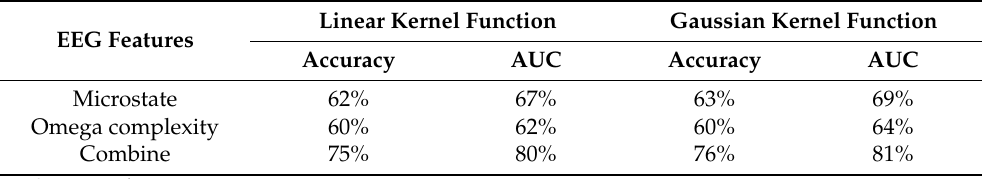
Figure 4. Receiver operating characteristic curves for spatial (microstate), temporal (omega complexity), and their combination using the SVM model based on Gaussian kernel function (left) and linear kernel function (right). Table 4. SVM classification while discriminating ScD and HCs